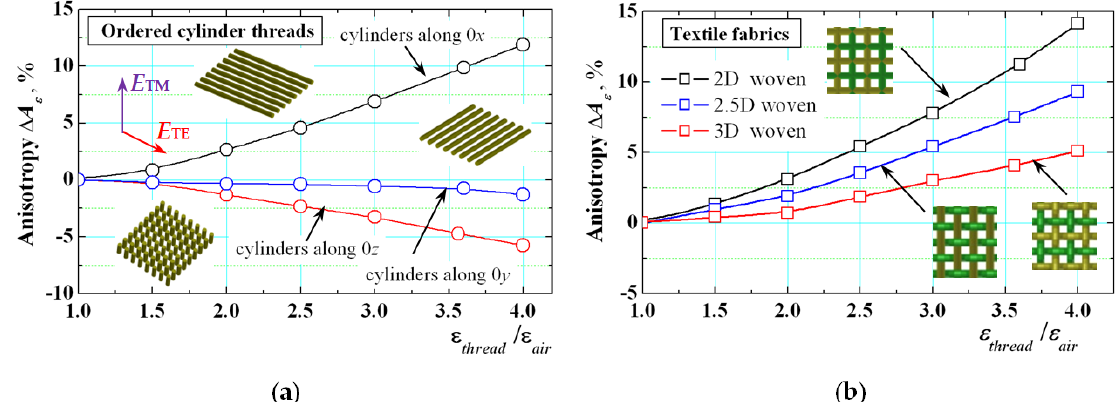
Figure 5. Dielectric constant anisotropy of artificial textile samples versus the ratio between the dielectric constant of the threads and air ε thread / ε air : ( a ) for ordered straight cylinders, orientated along axes 0 x , 0 y or 0 z ; ( b ) for 2D, 2½D and 3D woven fabrics in Ku-band (see Figure 6) (Arrows: E fields of the used TE and TM modes).